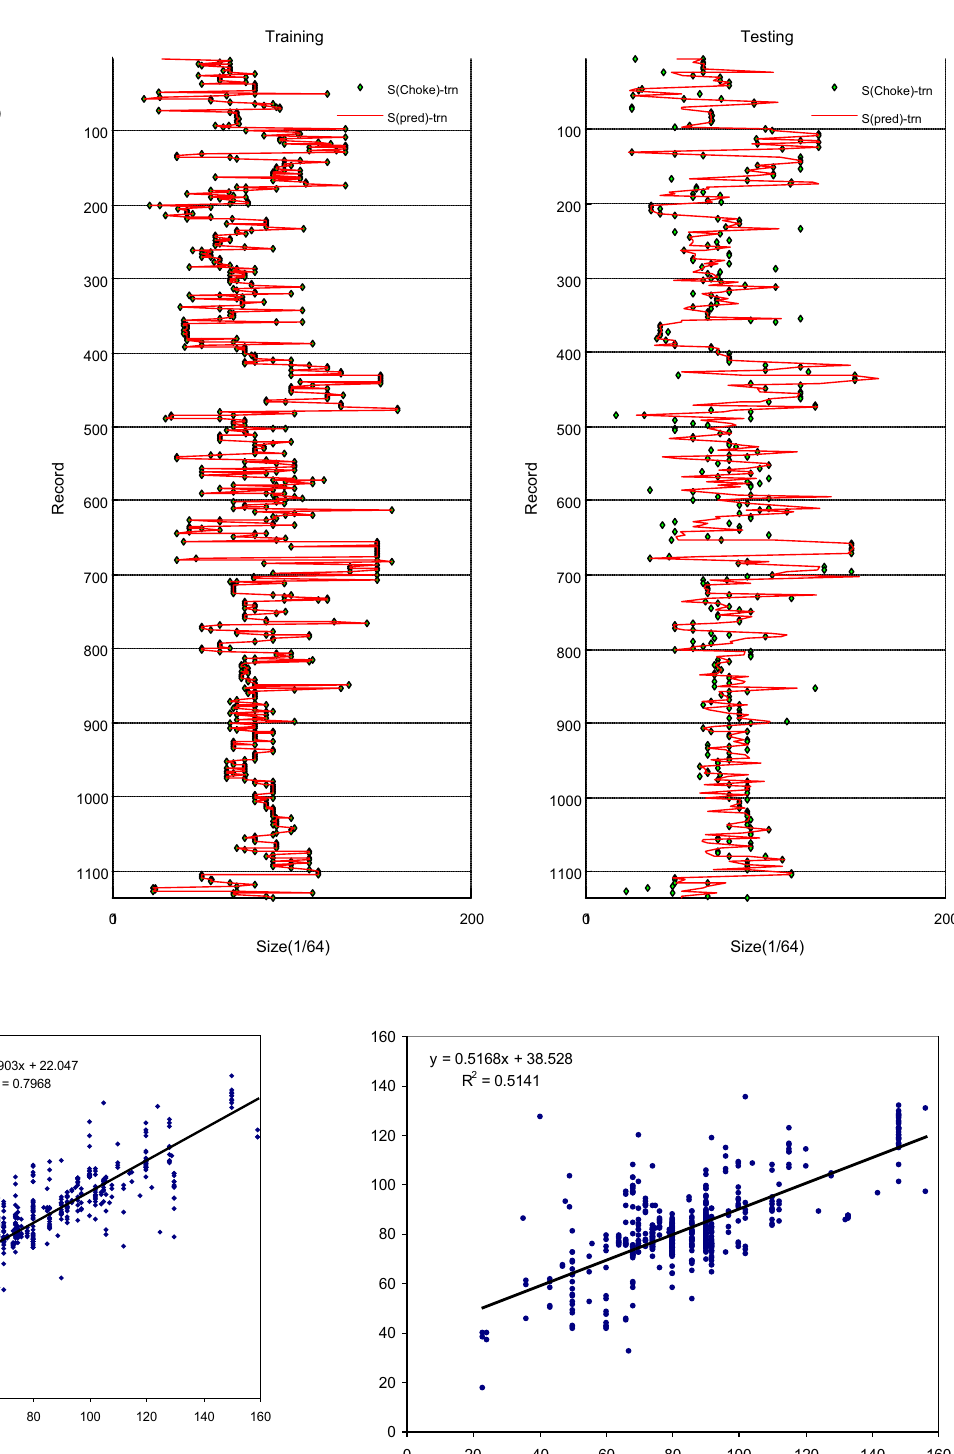
Fig. 15 Actual versus predicted choke size for RBF model testing (spread =